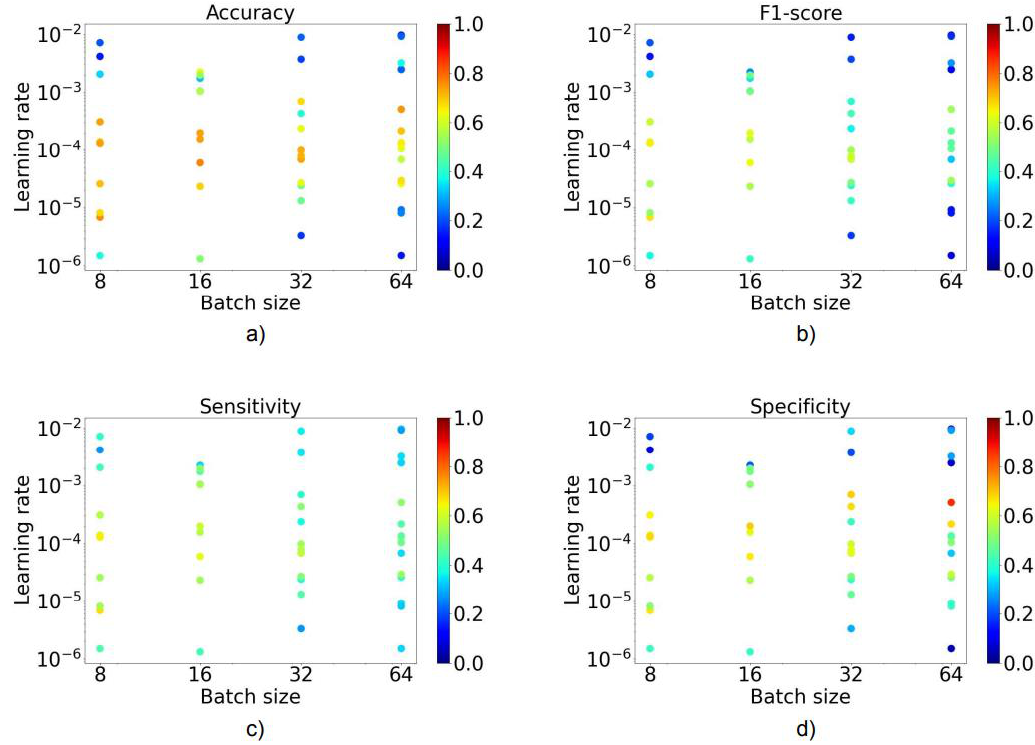
Figure 2. The impact of learning rate and batch size on accuracy in ( a ), F1-score in ( b ), sensitivity in ( c ), and specificity in ( d ). Each dot corresponds to an experiment. Red indicates a value closer to one and blue closer to zero.